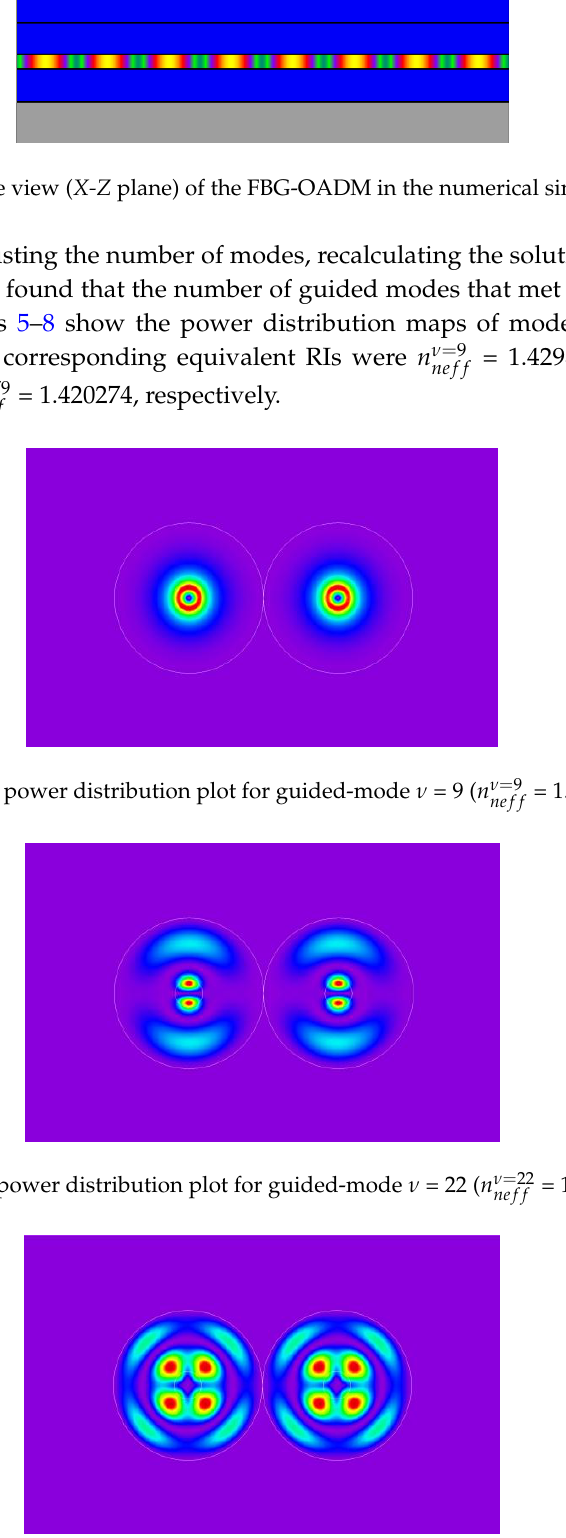
Figure 7. 2D power distribution plot for guided-mode ν = 56 ( 𝑛 𝑛𝑒𝑓𝑓𝜈=56 = 1.422949).